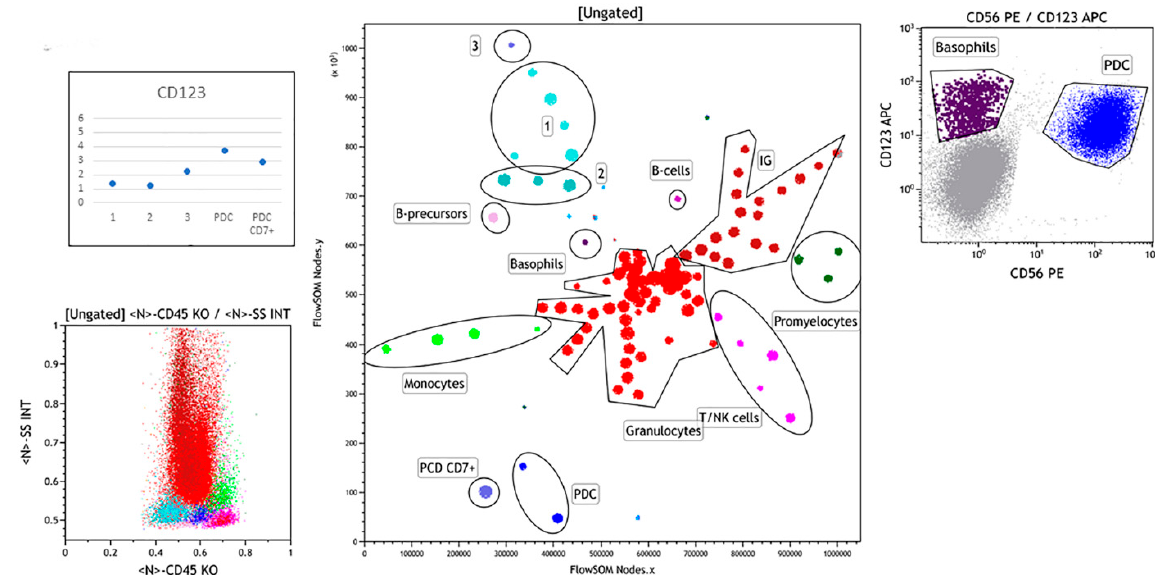
Figure 6. FlowSOM analysis of Case 5. Minimal spanning tree is shown in the middle panel. In this CMML case with evolution towards BPCDN FlowSOM segregates three nodes as normal PDC ( n = 2) or CD7+ PDC ( n = 1) that merge in a single cluster in the CD45/SSC scattergram ( bottom left ) (Supplementary Table S8). Normalised MFI of CD123 expression is given in the upper left diagram. The upper right scattergram, obtained from the same sample analyzed with a BPDCN-focused panel, confirms the CD56+/CD123+ immunophenotype of these cells, clearly separated from the small population of basophils (enhanced display).